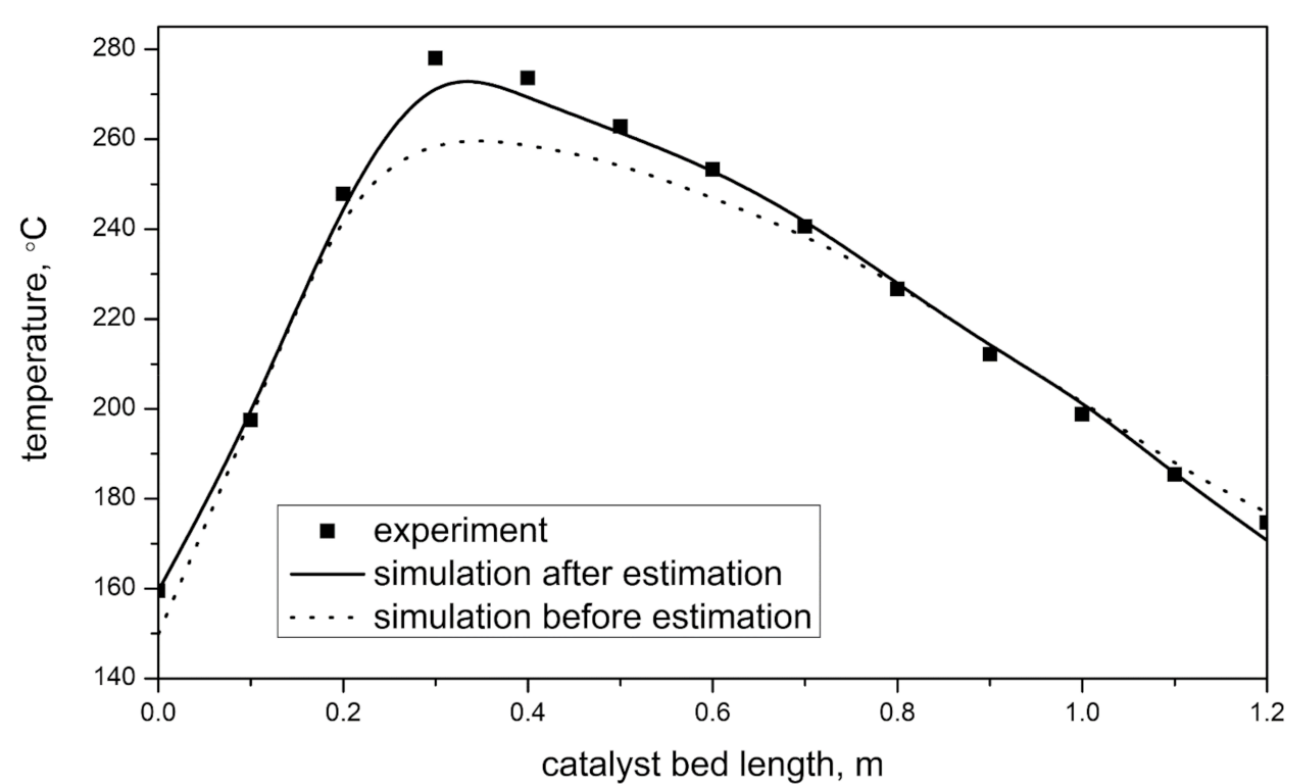
Figure 1. Verification of the model with experimental data from the unit tube; temperature vs. catalyst bed length.